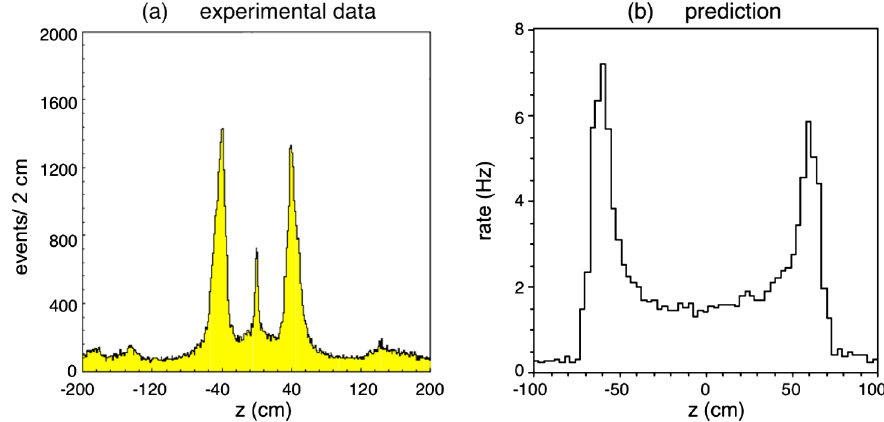
FIG. 12. (a) High rate of localized monotracks (protons) in KLOE until 2001 understood as photoproduction ep ð n Þ ! (cid:2) e ! p(cid:3) 0 ð (cid:3) (cid:1) Þ e , induced by Touschek particles hitting the beam pipe support; (b) prediction from full simulation of Touschek particles into